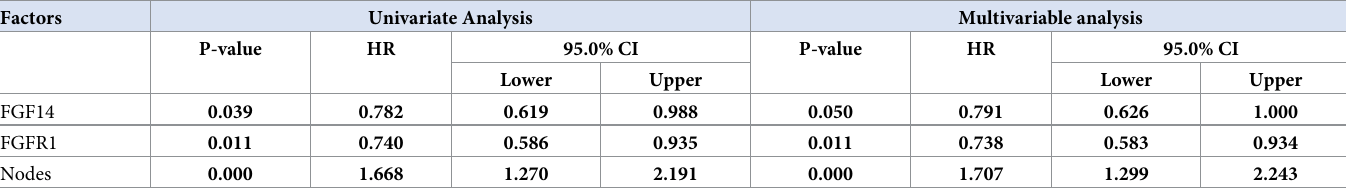
Table 3. Univariate and multivariate analysis of genes for overall survival in cohort